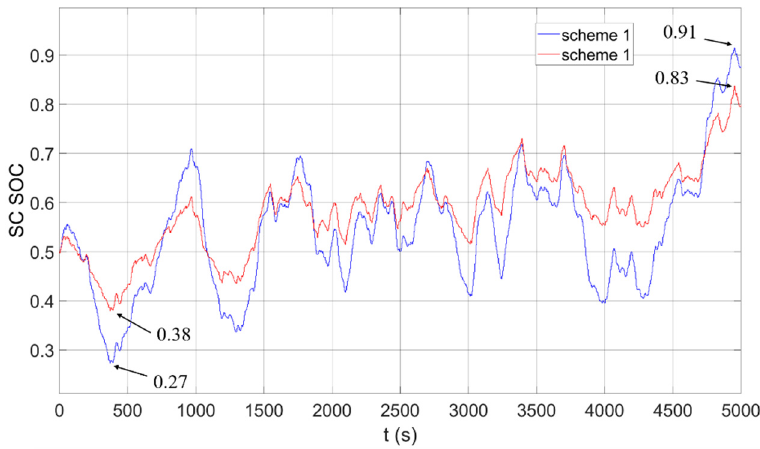
Figure 17. Supercapacitors SOC comparison.